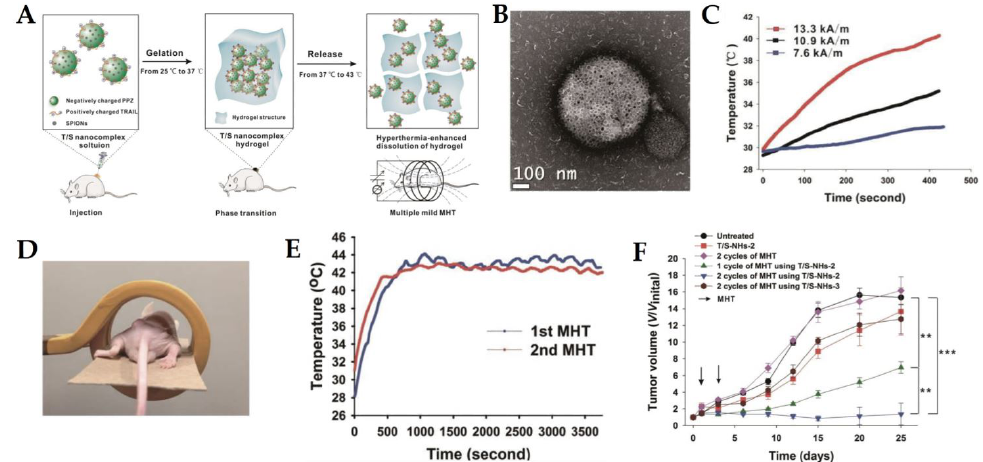
Figure 6. ( A ) Schematic diagram of the thermosensitive magnetogel developed by Zhang et al. based on positively charged tumor necrosis factor-related apoptosis-inducing ligand (TRAIL) and hydrophobic superparamagnetic iron oxide nanoparticles, complexed with negatively charged poly(organophosphazene) polymers, which TRAIL-SPION nanocomplex release from hydrogel is enhanced at 43 ◦ C under multiple MHT. ( B ) TEM representation of TRAIL/SPION nanocomplex. ( C ) Temperature versus time graphs of TRAIL-SPION nanocomplex at 0.5 mg Fe/m over different alternating magnetic field amplitudes and a constant frequency of 366 kHZ. ( D ) Schematic illustration of the magnetic hyperthermia therapy device for in vivo study of the nanocomplex efficiency on a U-87 MG-bearing nude mouse. ( E ) Tumor temperature monitoring over 2 cycles of MHT after a single injection of the nanocomplex. ( F ) Tumor volume (V/Vinital) versus time after treatment for single and combined therapy, with the arrows indicating the day of MHT application. Adapted from [42] with permission from Elsevier,